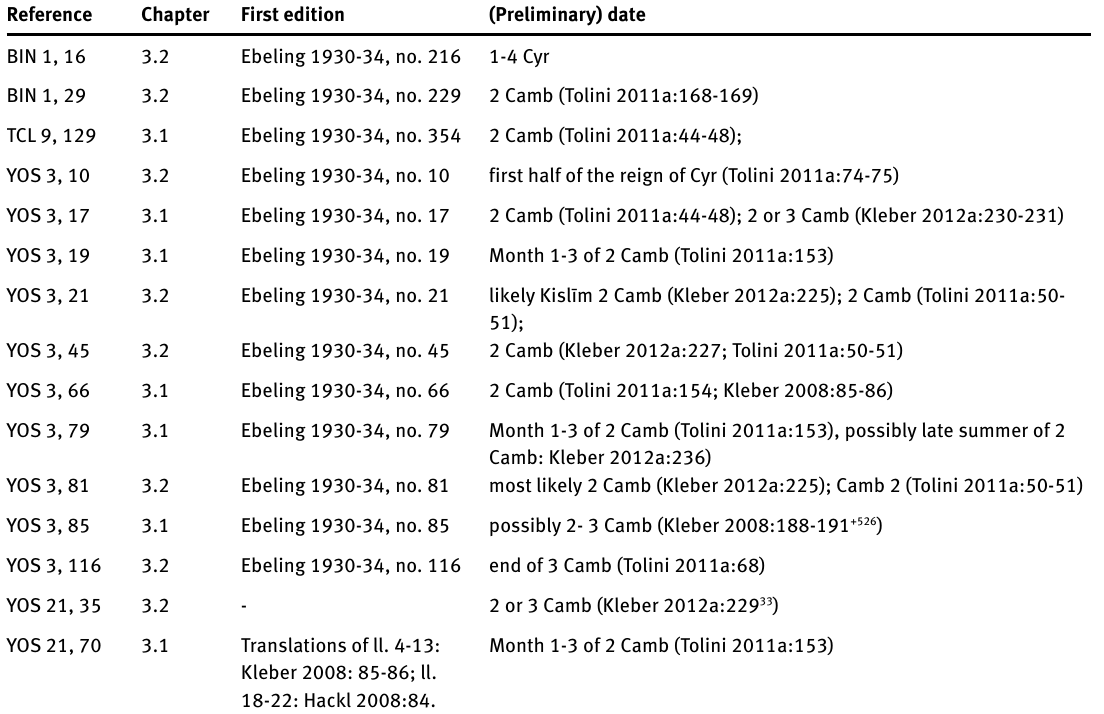
Table 1: Translated and transliterated texts. With the exception of TCL-texts, which are housed in the Louvre, all letters can be found at Yale University, New